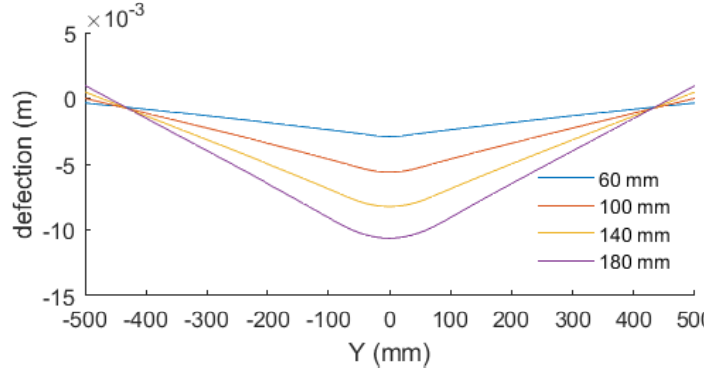
Figure 16. Comparison of processing efficiency.